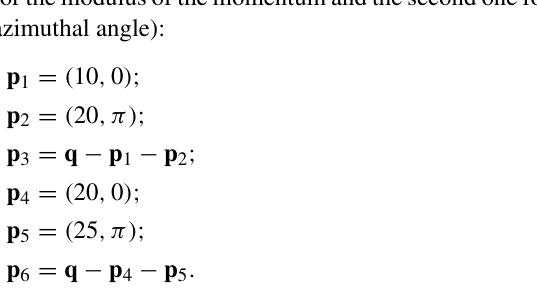
zero. This becomes clear since all p i are chosen to be dif- ferent from each other and hence none of the Dirac delta functions in the initial condition is